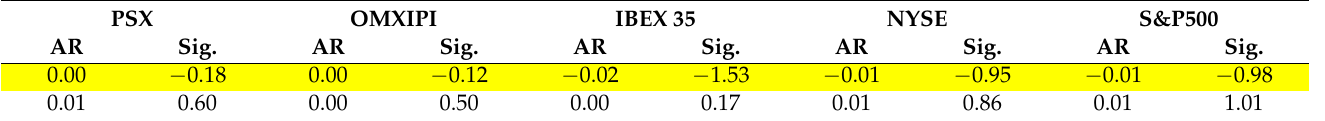
Table A18. Abnormal returns of the (0, +1) event window (Prime Minister of Iceland announced his resignation).